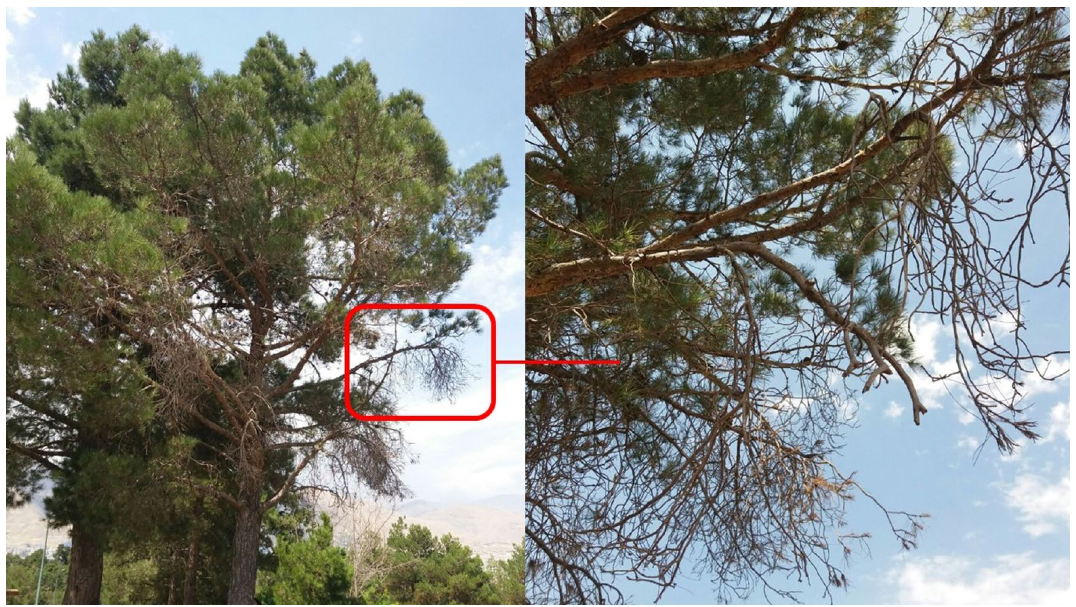
Figure 9. Dieback symptom on Pinus eldarica